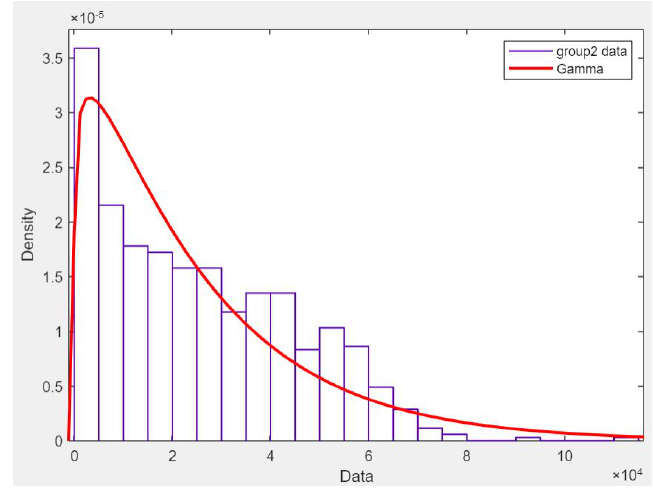
Figure 11. HISTFIT for group 2 in Category C.